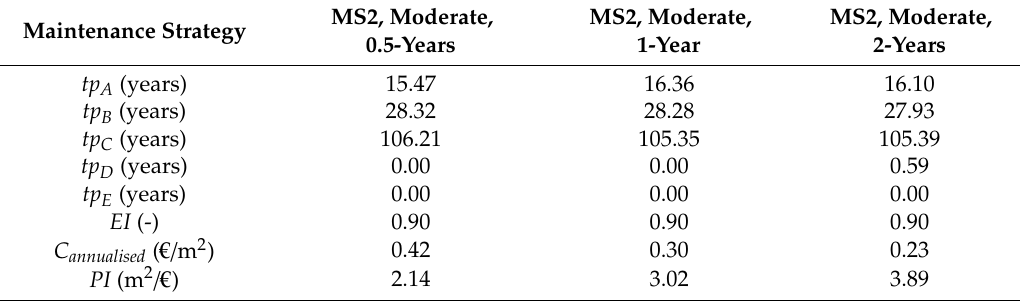
Table 8. E ffi ciency index and the performance indicator for the three inspection